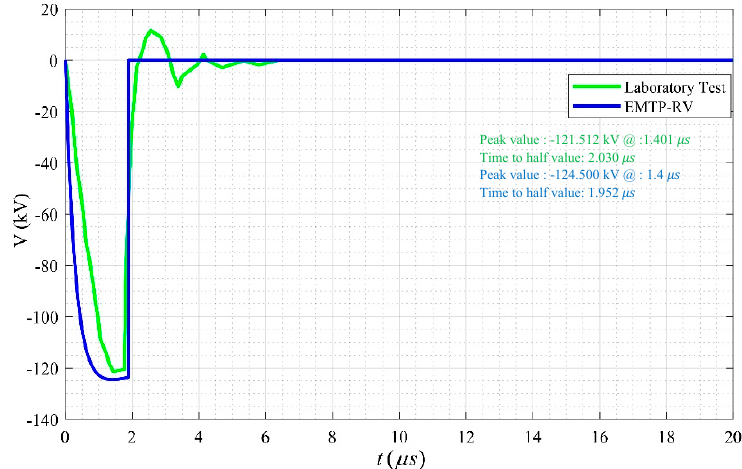
Figure 12. Applied impulse 125 kV in the presence of the spark gap, laboratory test and EMTP-RV model.